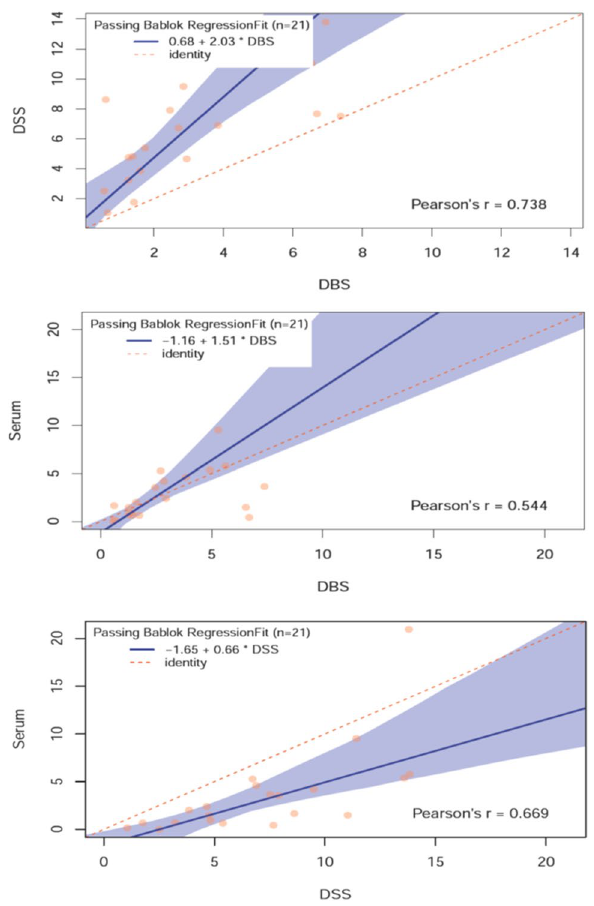
Figure 7. Example Passing–Bablock regression of the expression of 200 proteins across groups in matched serum, DBS, and DSS samples for